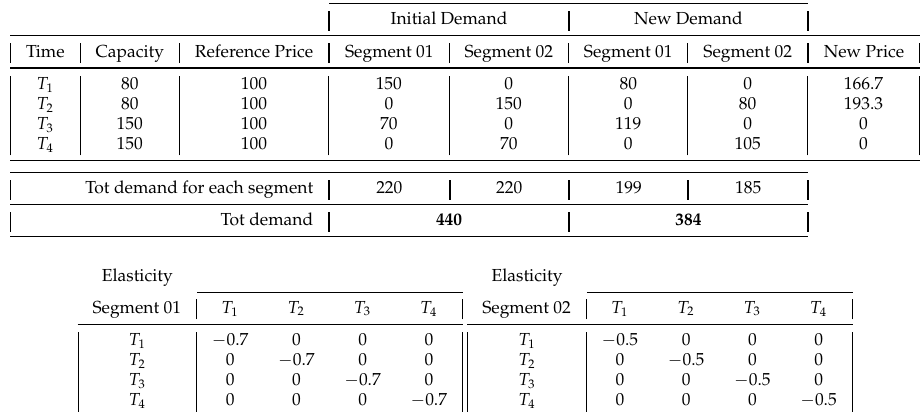
Table 4. Case Study 6.01—third sub-case, data, and